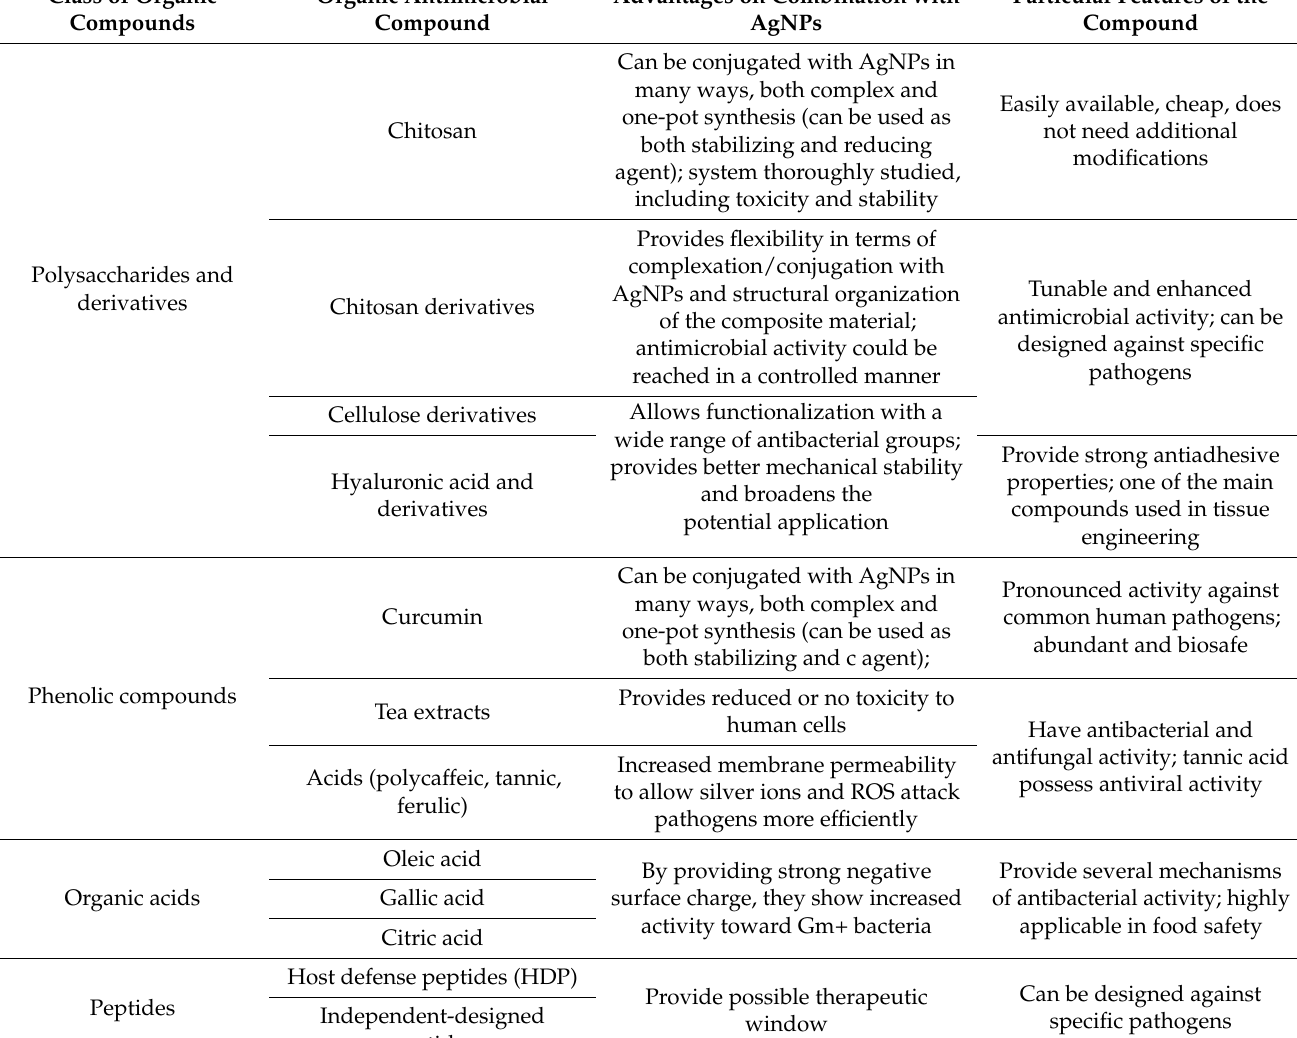
Table 1. Summary table with organic antimicrobials and the features of their use in combination with nanosilver. Class of Organic Organic Antimicrobial Advantages on Combination with Particular Features of the Compounds Compound AgNPs Compound